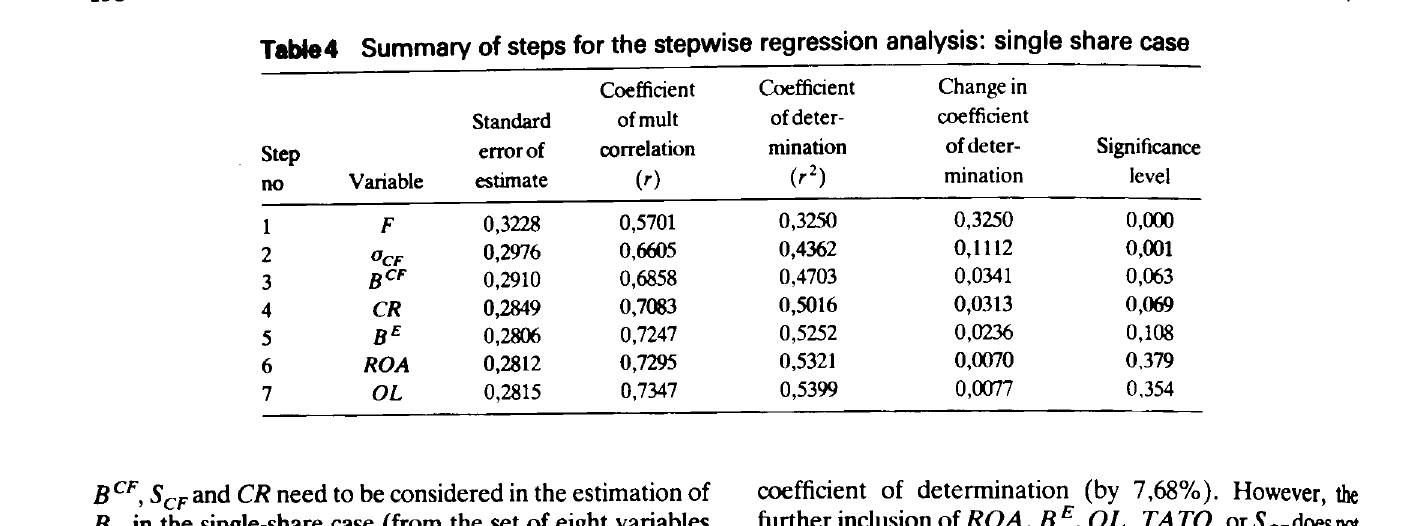
Table4 Summary of steps for the stepwise regression analysis: single share case